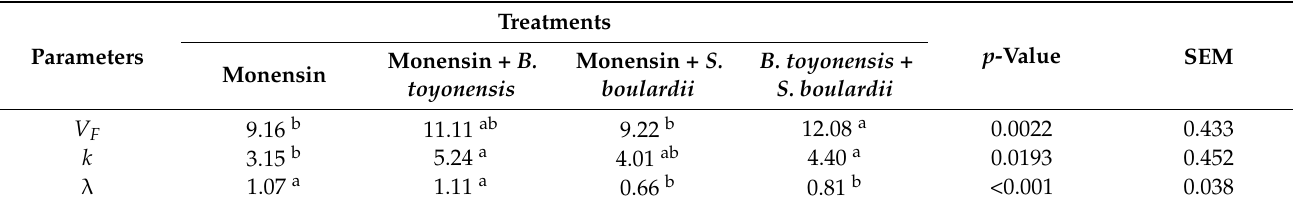
Table 4. Estimation of in vitro gas production parameters of corn silage with different feed additive combinations obtained by the Groot model.